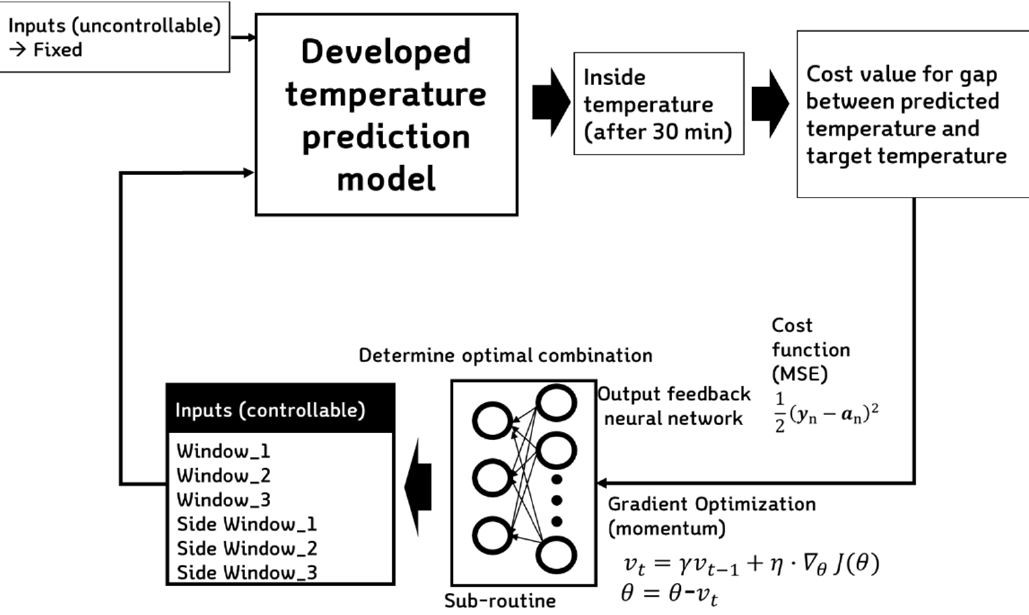
Figure 4. Structure of the output feedback neural network (OFNN) and operational direction.